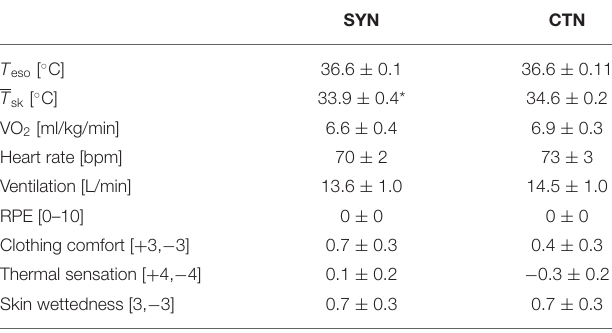
TABLE 4 | Baseline values of thermoregulatory, cardiometabolic, ventilatory, and perceptual parameters.